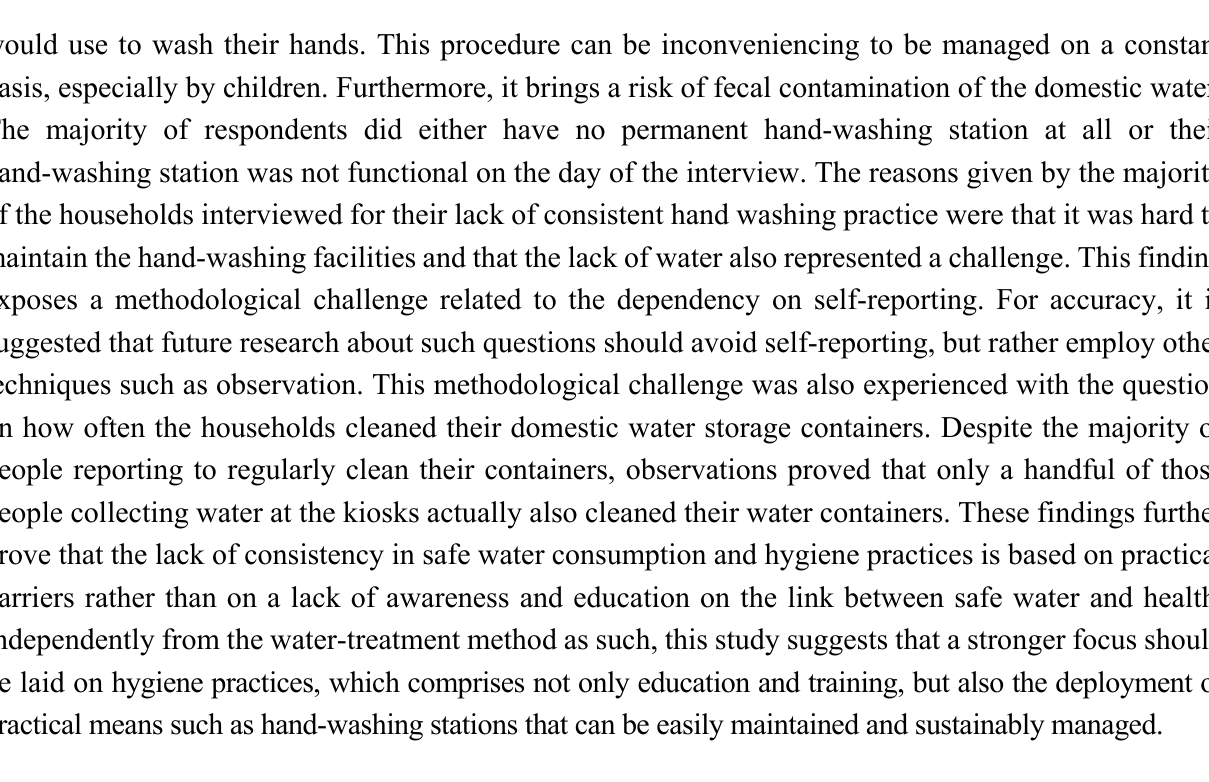
Table 2. Percentage of Kenyan households by water-treatment method used according to 2009 national demographic census